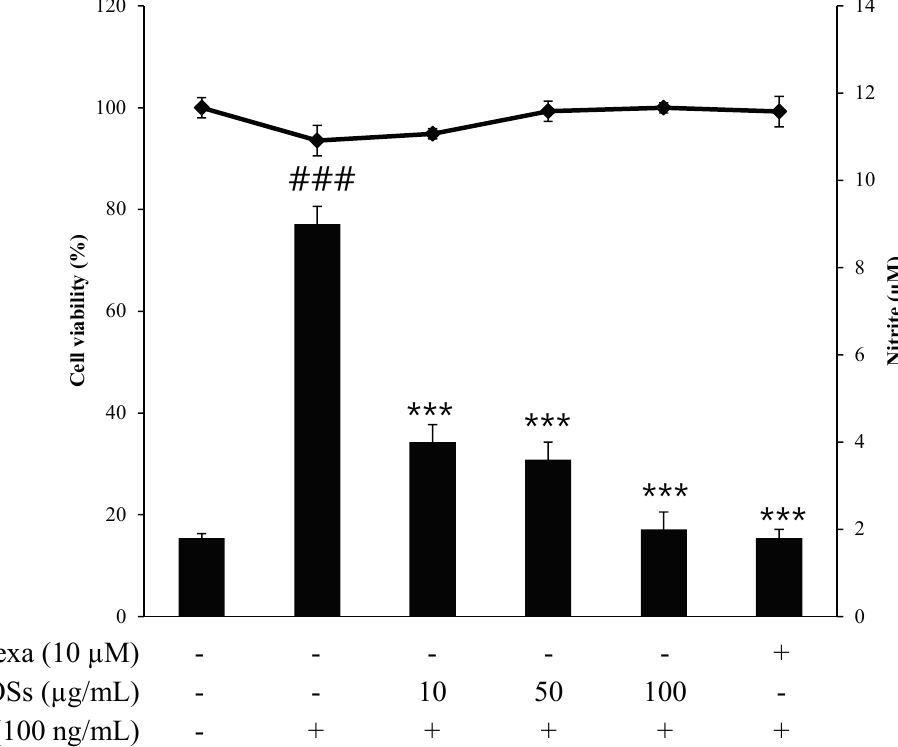
Figure 3. Cell viability and nitrite production of sulfated low molecular chitosan oligosaccharides (S-LMWCOSs) in LPS-stimulated RAW264.7 cells. RAW264.7